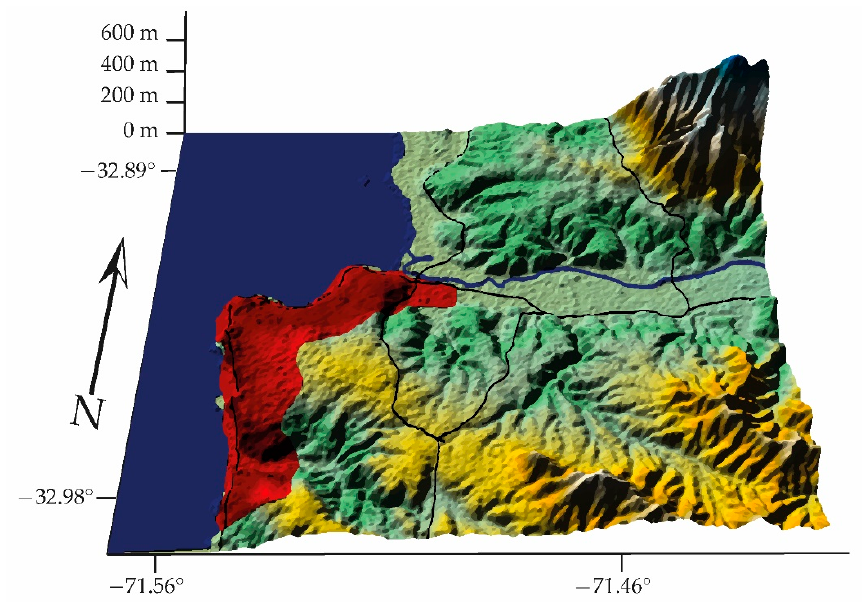
Figure 18. C K, Concón = 1.24 , the activity of micrometeorology dominates that of pollutants (GCS, WGS84).